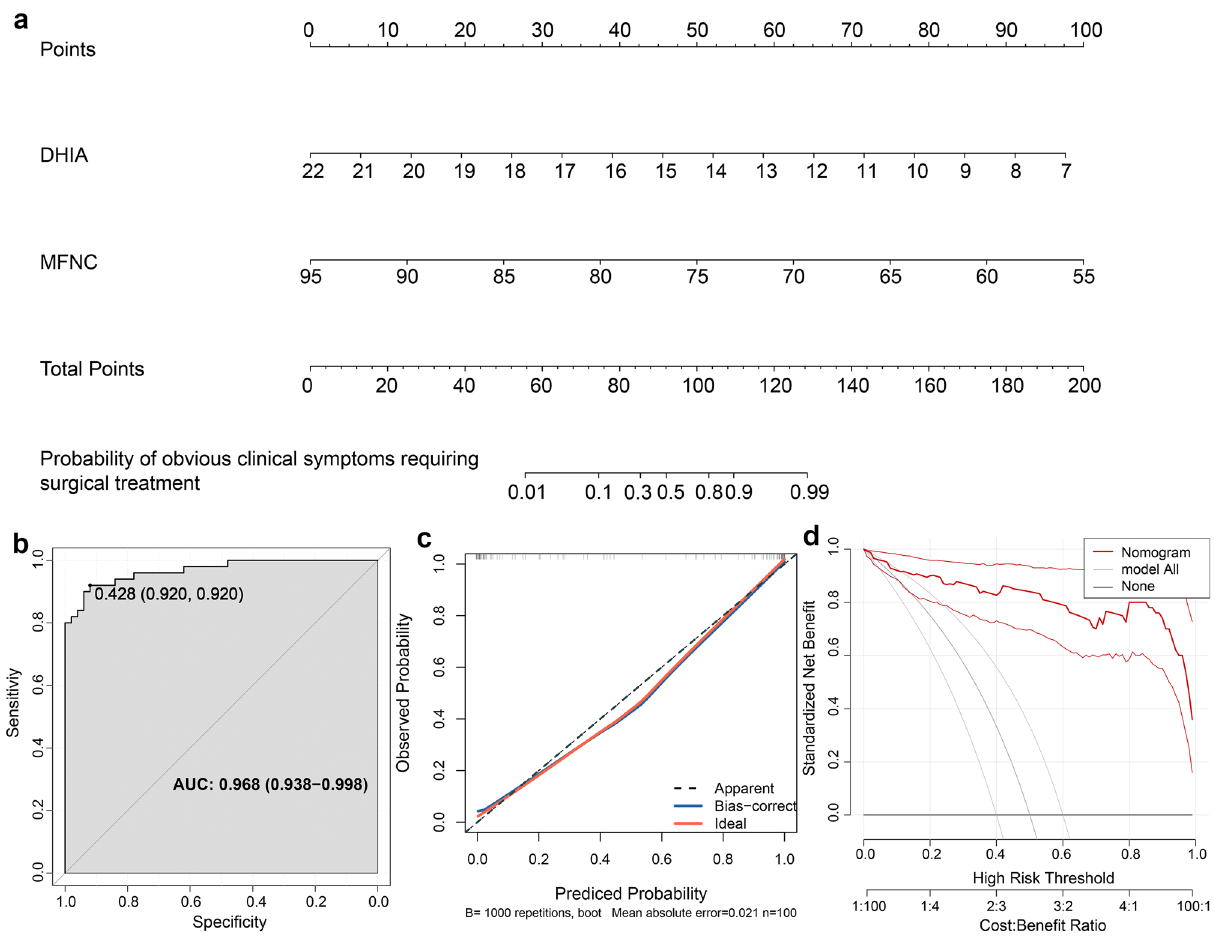
Figure 5. The development of a nomogram for predicting the likelihood of patients with severe symptoms requiring surgical intervention. ( a ) Details of the nomogram. ( b ) The receiver operating characteristic (ROC) curve indicated excellent discrimination by the nomogram. ( c ) The calibration curve exhibited strong agreement between the predicted and observed outcomes. ( d ) The decision curve analysis (DCA) curve exhibited a higher benefit for patients across a broad spectrum of predicted probabilities.